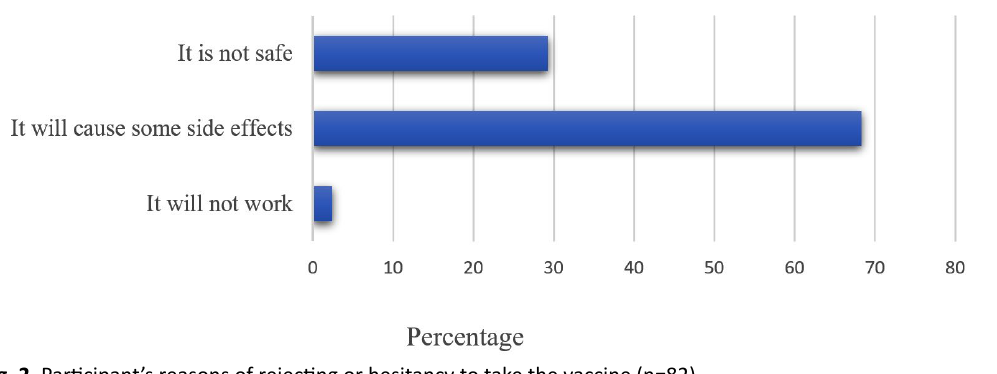
Fig. 2. Participant’s reasons of rejecting or hesitancy to take the vaccine